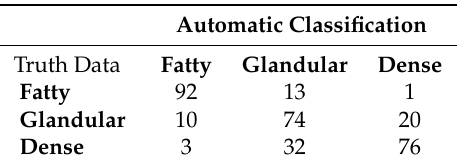
Table 6. Confusion matrix for automatic tissue classification using the Local Directional Pattern (LDP) descriptor for ROI size 256 ×